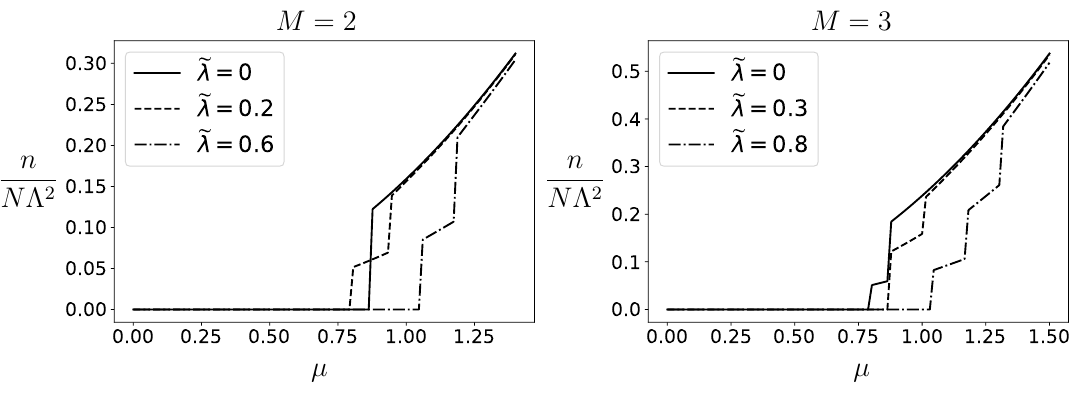
Figure 15 . Fermion number density at T = 0 with